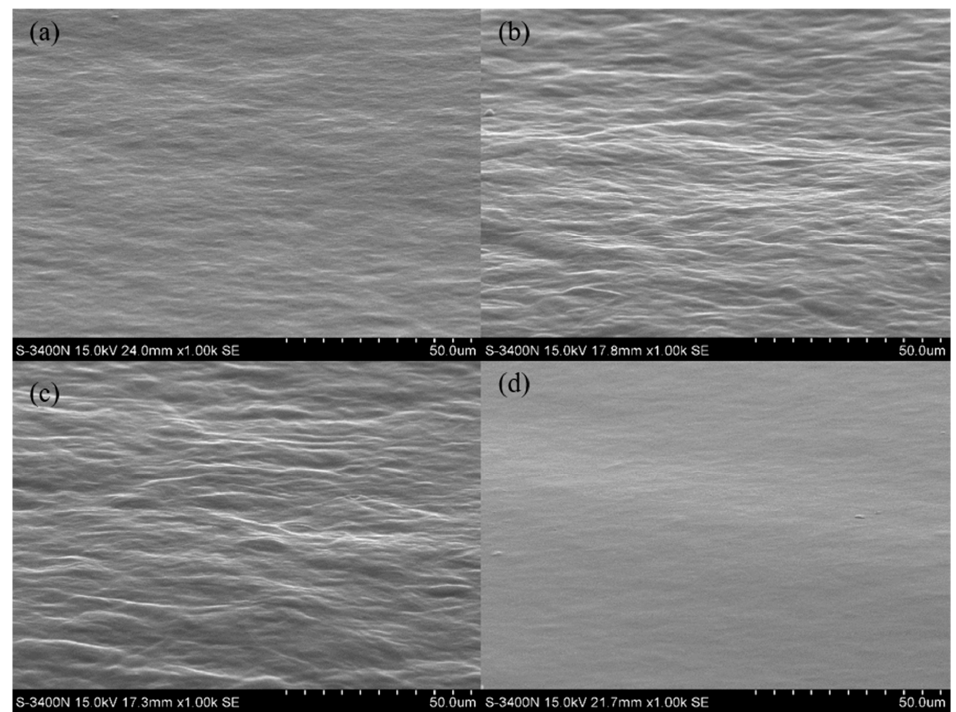
Figure 2. SEM topographic images of PU1 , PU2 , PU3 , and PU4 films, respectively. The CO contents are ( a ) 1.72%, ( b ) 3.44%, ( c ) 5.16%, and ( d ) 6.88%, without the addition of phenolic epoxy resin.